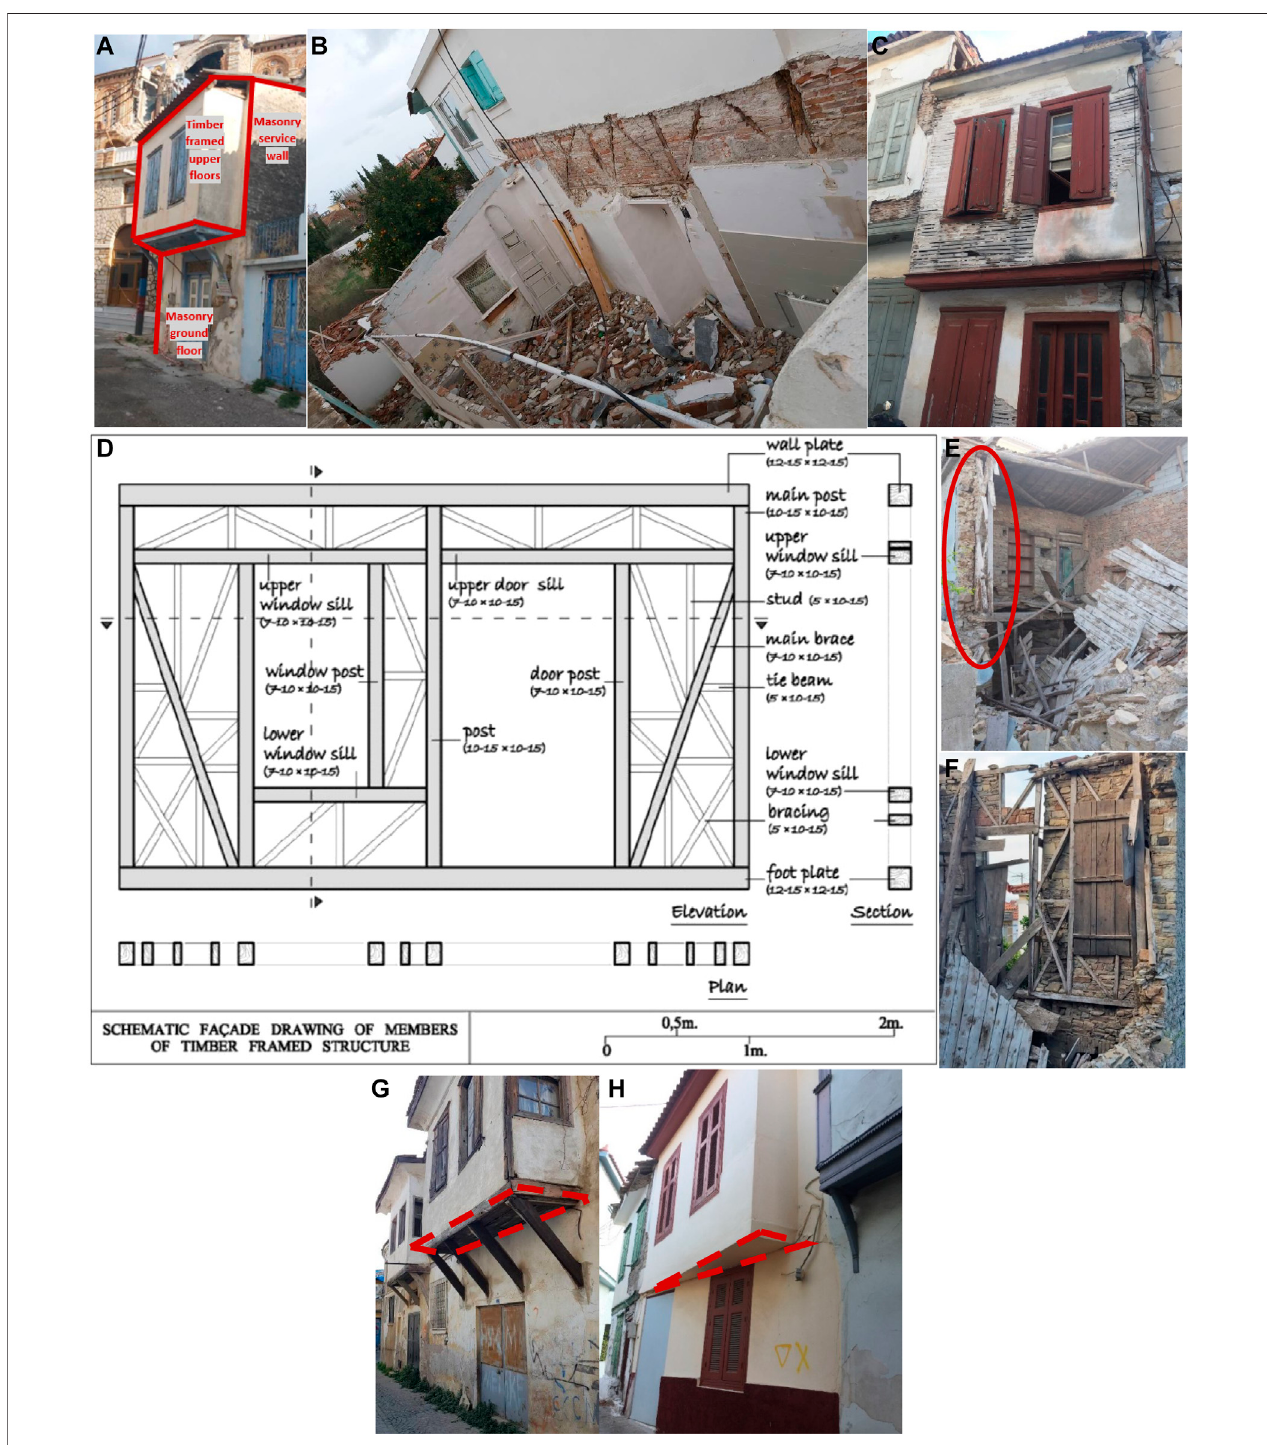
FIGURE 1 | (A) General construction features of hybrid timber-masonry structures (in Samos, Greece) with examples to (B) in fi lled and (C) cladded typologies (in Samos, Greece); (D) The schematic showing the general timber frame organization based on a Western Anatolian case, Turkey (Diri, 2010) (E,F) Examples of timber framed walls with an additional external layer of masonry (in Samos, Greece); (G) a regular braced jetty (in Seferihisar, Turkey); (H) an irregular cantilever jetty (in Samos, Greece).